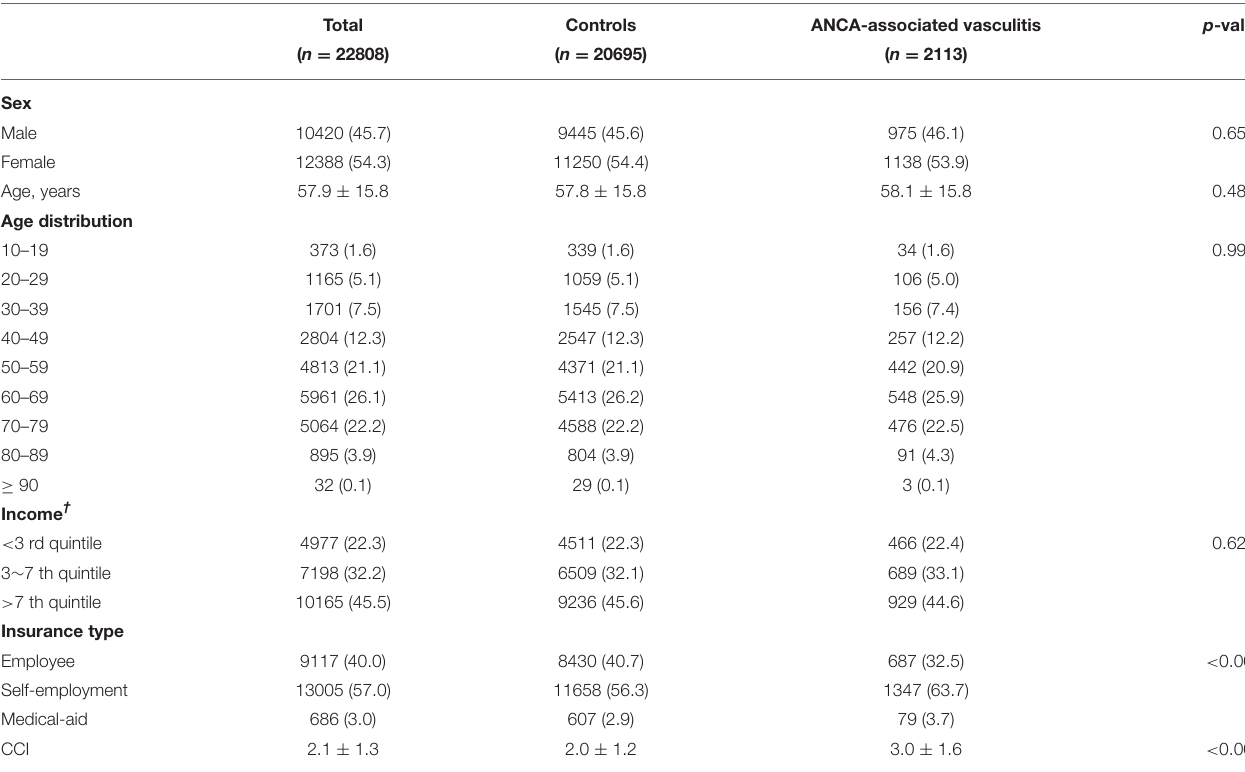
TABLE 1 | Baseline characteristics of patients with ANCA-associated vasculitis and controls.